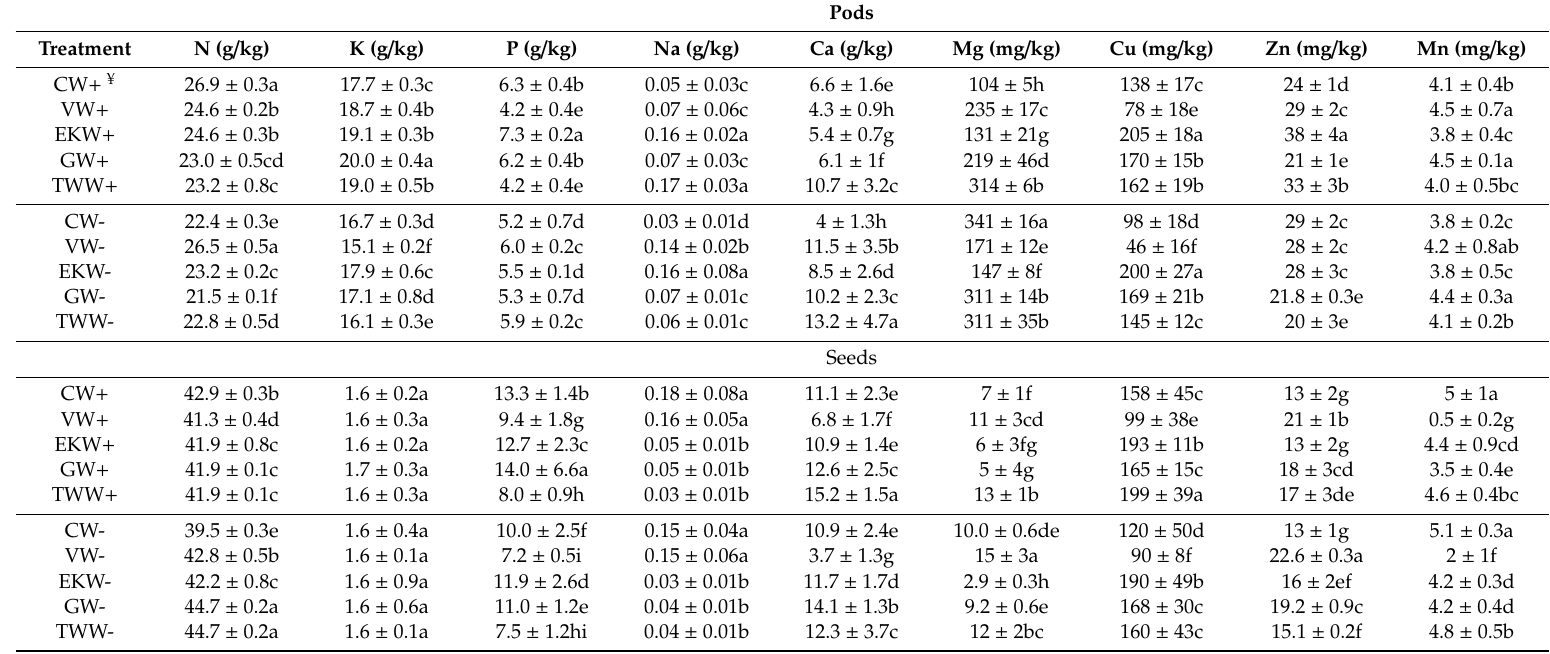
Table 4. Mineral composition of the studied pods (second harvest) and seeds of beans in relation to the irrigation regime, expressed on a dry weight basis (mean ± SD).